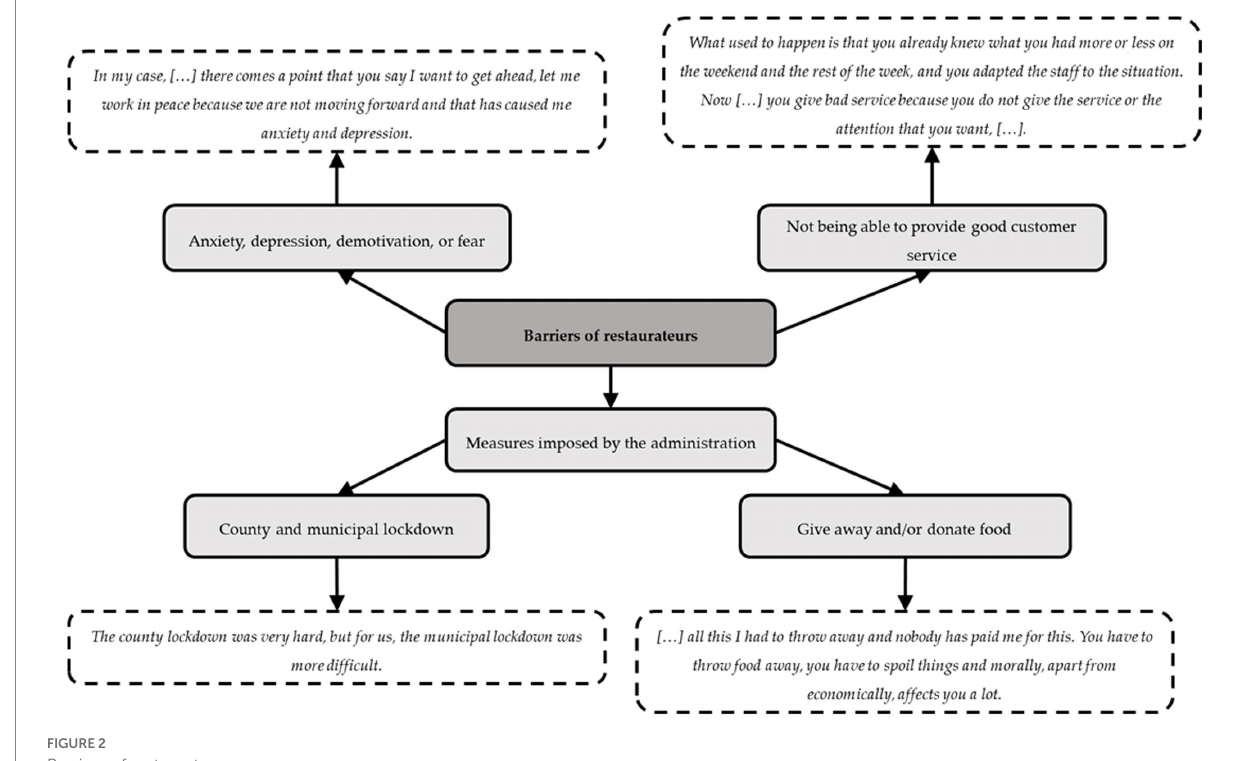
FIGURE 2 Barriers of